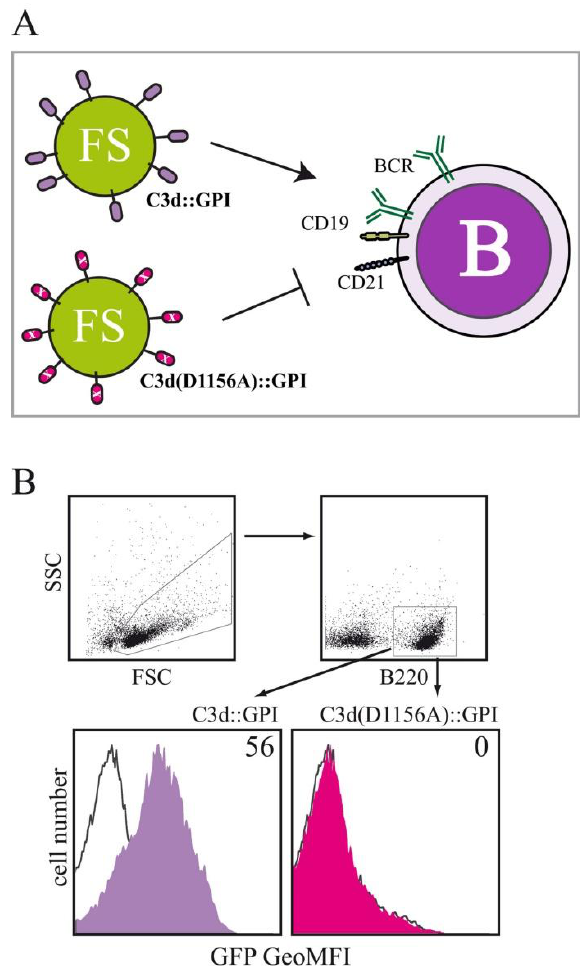
Figure 3. Binding of complement component C3d decorated VNP to B220 + murine splenocytes. ( A ) Scheme displaying the two different types of FS. FS decorated with C3d::GPI can very potently interact with murine B cells. FS decorated with C3d(D1156A)::GPI